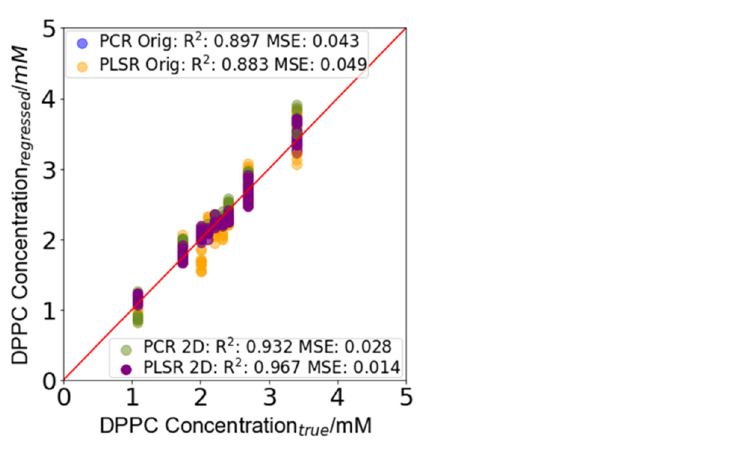
Figure 4. DPPC concentration prediction in the test set samples. The prediction error for each of the models is summarized in Table 3 (further information can be found in Supplementary Information). The largest prediction interval for the PCR Orig model was +0.38 mM, − 0.46 m, that for the PLSR Orig model was +0.67 mM, − 0.78 m, that for the PCR 2D model was +0.30 mM, − 0.38 m, and that for the PLSR 2D model was +0.29 mM, − 0.37 mM. Table 3. Summary of the maximum and minimum prediction intervals for each model. The max interval range indicates the maximum range of the prediction interval for the point with the largest prediction interval within the test set.